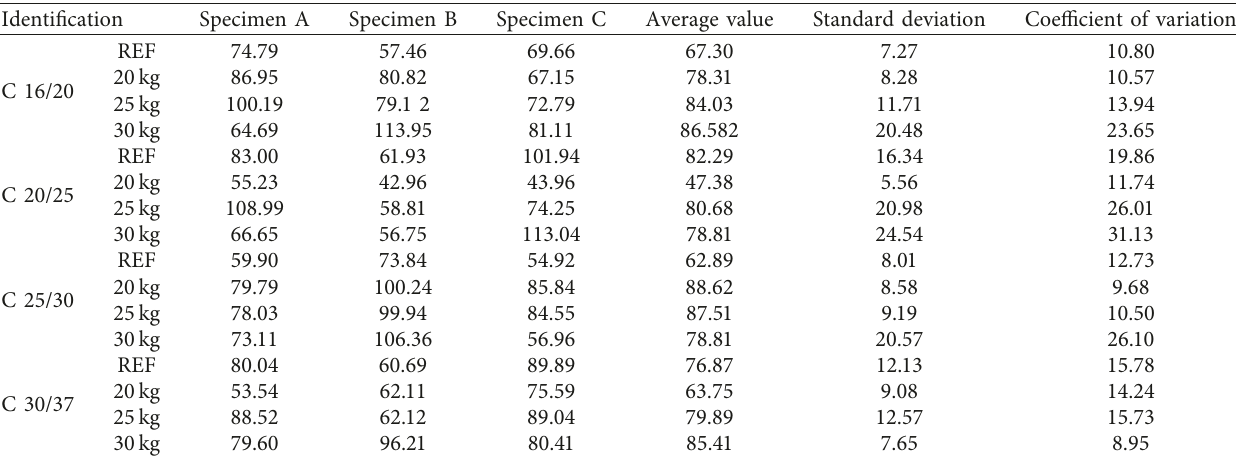
Table 8: Results of calculations of specific fracture energy from the working diagrams in